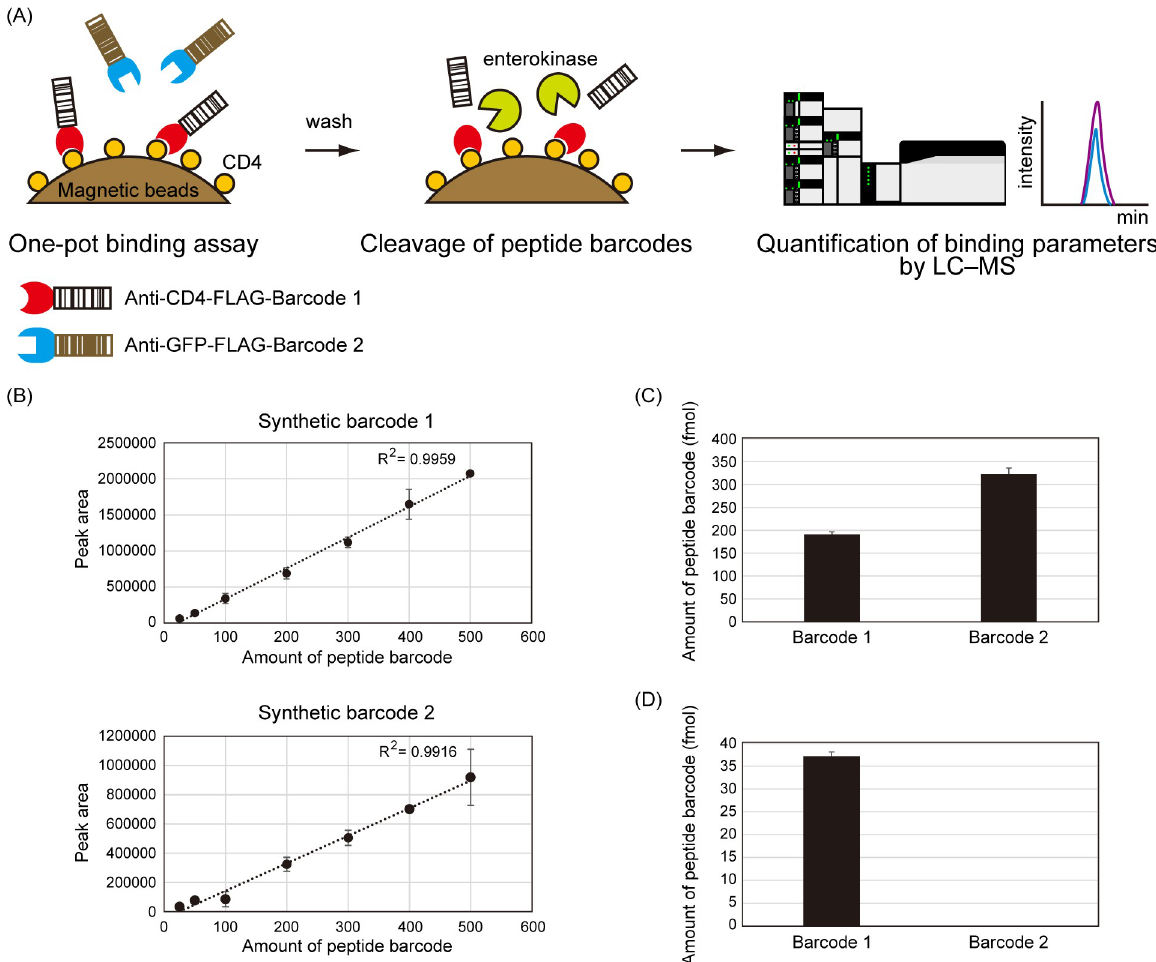
Fig 4. Quantification of binding activities of the barcoded nanobodies by LC–MS. (A) Experimental scheme to quantify the binding activities of the nanobodies by LC–MS. The barcoded nanobodies are mixed with CD4-coated magnetic beads in one pot, and non-specific nanobodies are washed out. The peptide barcodes are cleaved on beads by a specific protease, enterokinase. Then, eluted peptide barcodes are quantified by mass spectrometry for the evaluation of binding activities. (B) The quantitativity of SRM of each peptide barcode. Synthetic peptide barcodes were serially diluted and quantified by LCMS-8060. Each peptide barcode was successfully analyzed with high sensitivity and quantitativity. Each value represents the mean ± standard deviation of three technical replicates. (C) Quantification of each peptide-barcoded nanobody. The peptide barcodes were cleaved from 250 fmol of each nanobody, and quantified by LCMS-8060. Each value represents the mean ± standard deviation of three independent experiments. (D) Quantification of the binding strength of the peptide-barcoded nanobodies. The amount of nanobodies bound on the CD4-coated magnetic beads was quantified by LCMS-8060. The peptide barcode fused with anti-CD4 nanobody was specifically detected. Each value represents the mean ± standard deviation of three independent